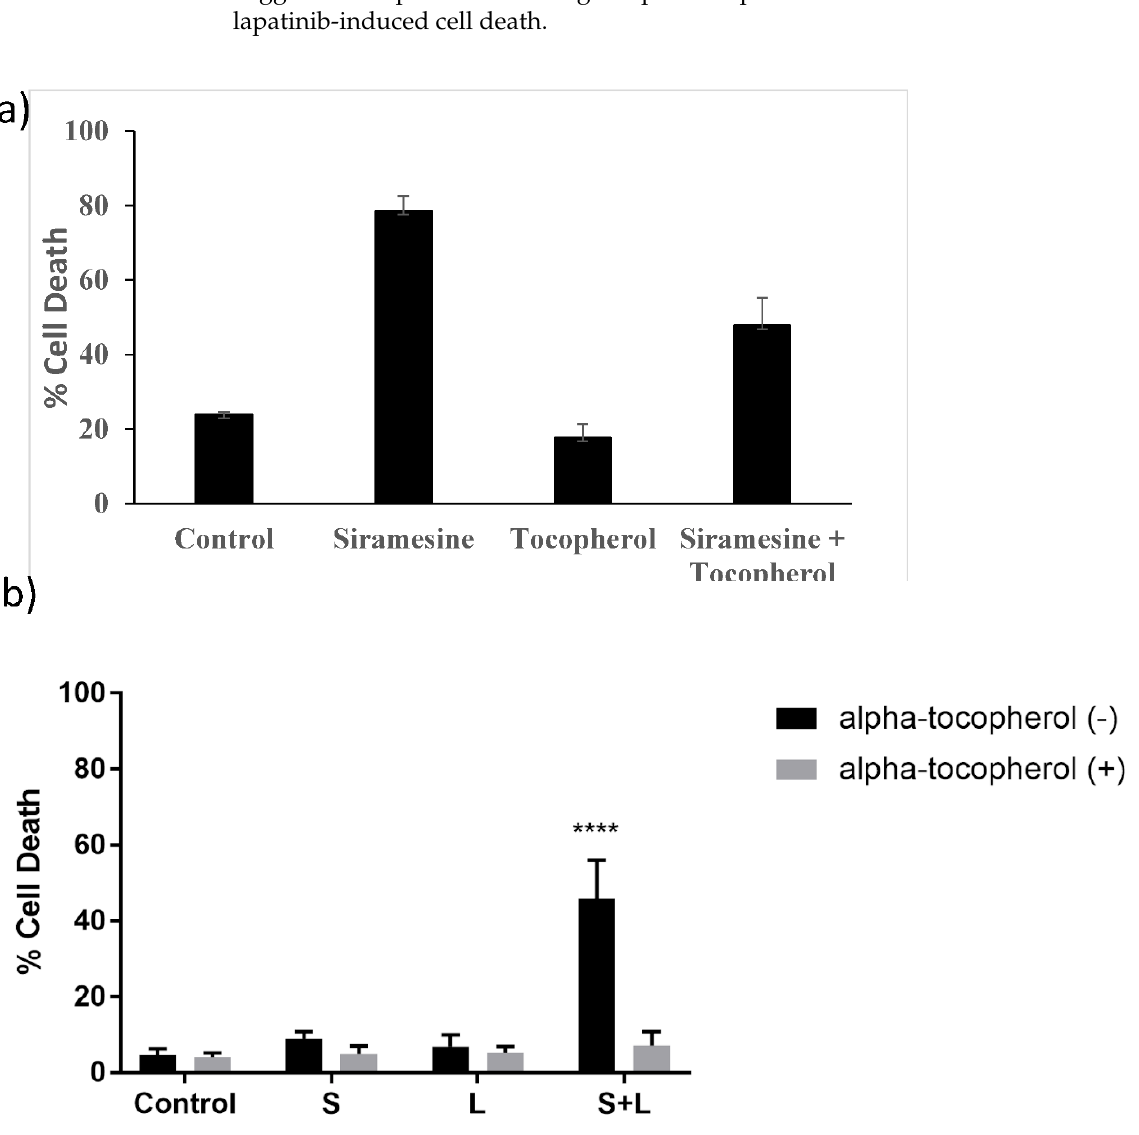
Figure 8. Siramesine and lapatinib-induced cell death is blocked by antioxidant alpha-tocopherol . ( a ) PC3 cells were treated with 10 μ M siramesine for 24 h in the presence or absence of 10 μ M alpha-tocopherol. Cell death was determined by Trypan blue exclusion assay. ( b ) PC3 cells were treated with 2.5 μ M siramesine, 5 μ M lapatinib or in combination in the presence or absence of alpha-tocopherol for 24 h. Cell death was determined by Trypan blue exclusion assay. The error bars represent standard error of three independent experiments and * presents statistical significance of p < 0.05.